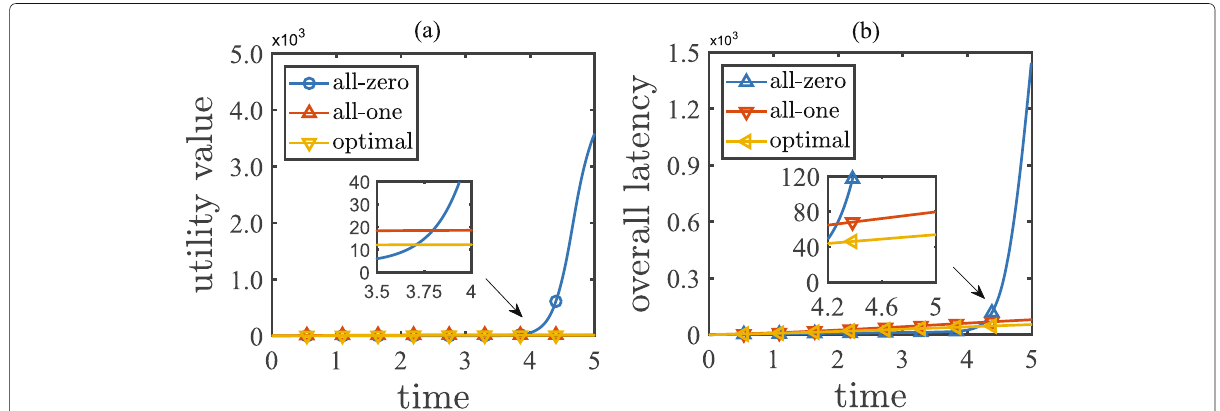
Fig. 7 Performance results of Example 1: (a) the utility function over time; (b) the accumulated overall latency over time